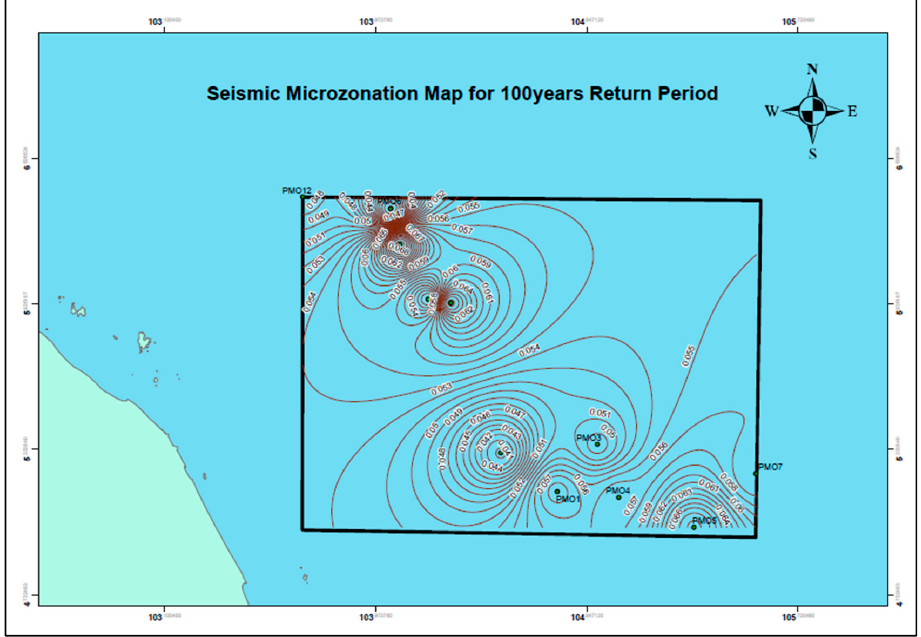
Figure 8. Seismic microzonation map for a 100-year return period.